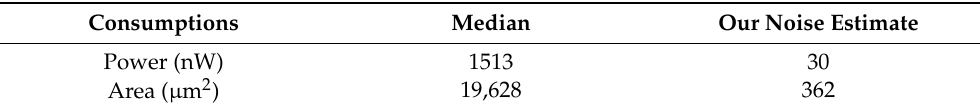
Table 2. Post-physical synthesis consumptions of noise approaches candidates: MAD and our three-point median based method.